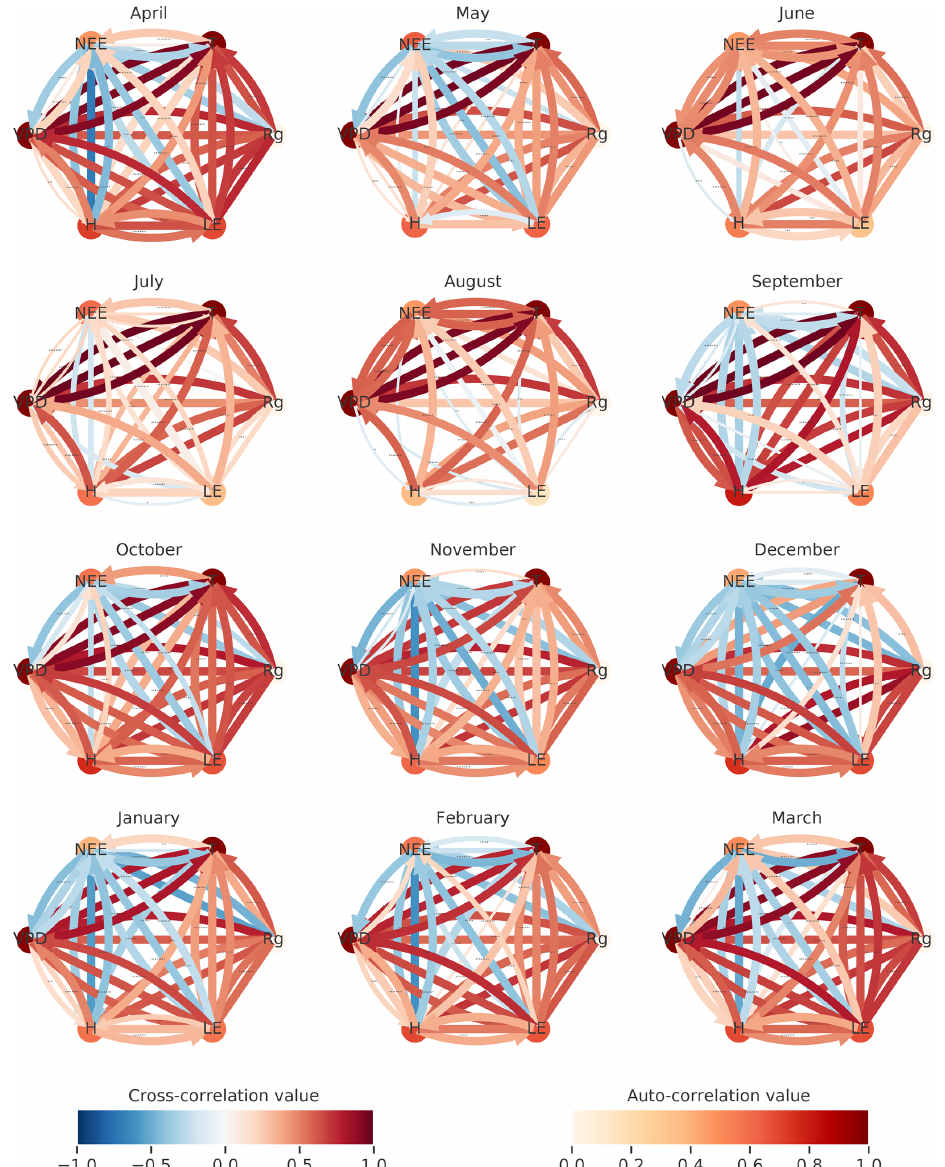
Figure A6. The same as Fig. 5 but using simple correlation analysis to estimate the graph structures. The number of significant occurrences of a link is given by its width. The link strength, given by the link colour, is calculated by averaging the significant links of the towers. Link labels indicating the lag were removed to improve link visibility. They typically ranged from 1 to 8 (full range of possible lags). The resulting graphs are shown for April 2014 until March 2015. The significance threshold is